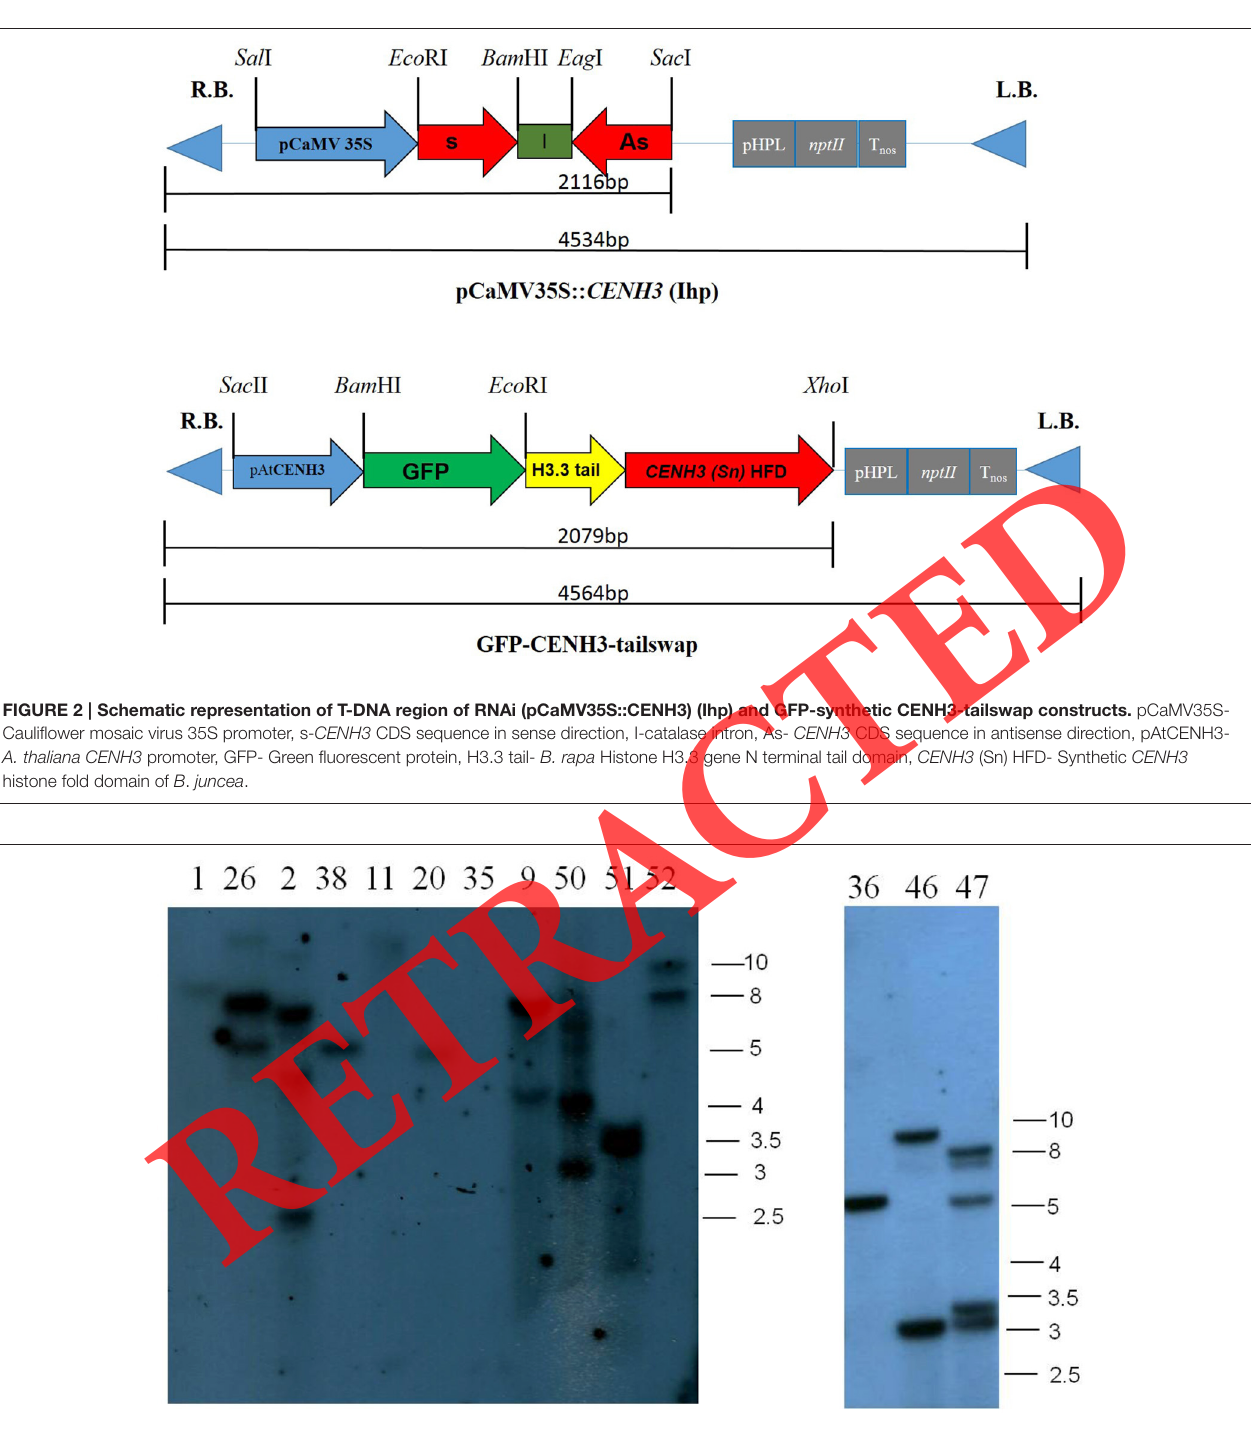
FIGURE 3 | Southern blots of B. juncea transgenics. Number indicates different events. NPTII gene was used as a probe. Fragment size in kb is indicated on the right.